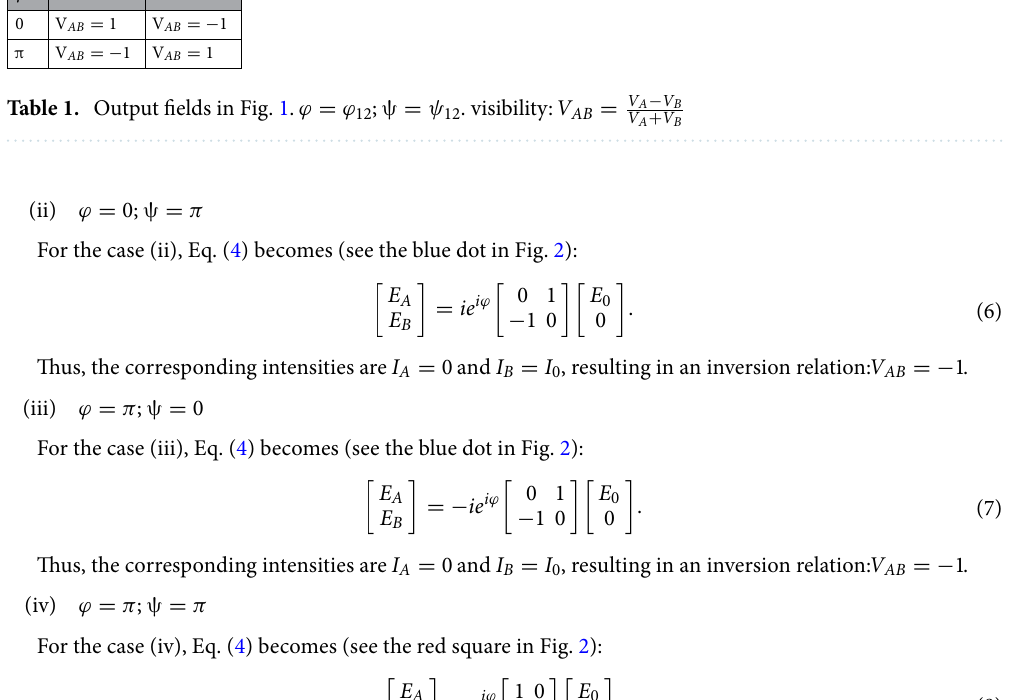
Table 1. Output fields in Fig. 1. ϕ